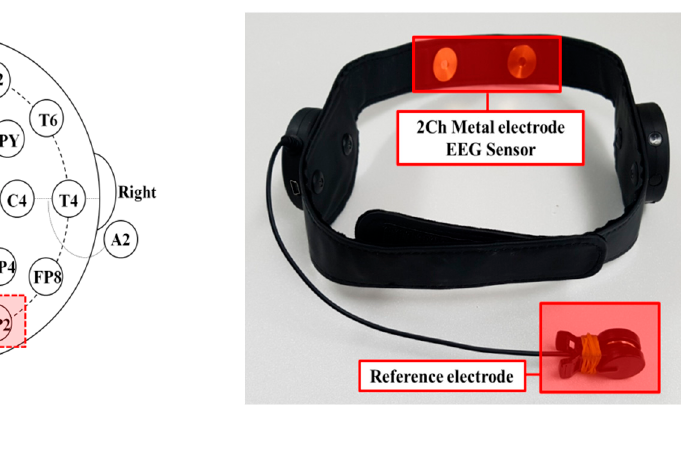
Figure 5. EEG measurement system and sites.